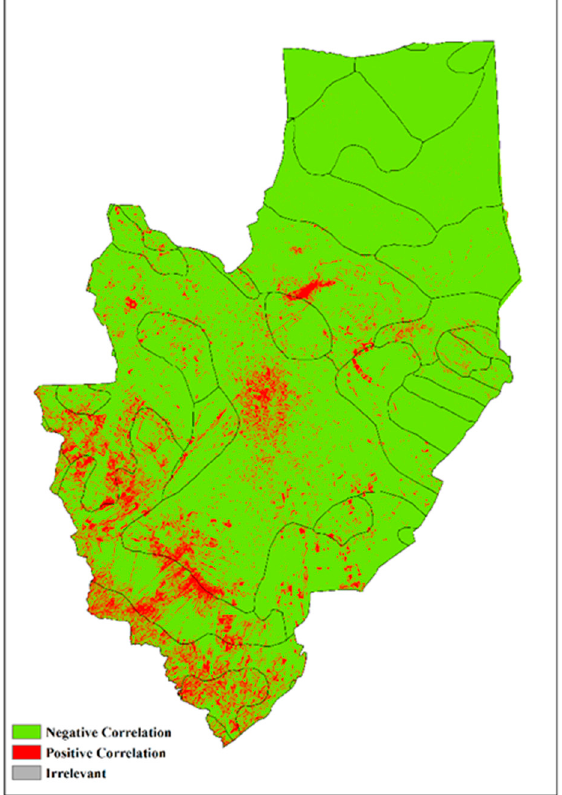
Figure 12. Spatial distribution of Pearson correlation coefficient between annual surface albedo and temperature.